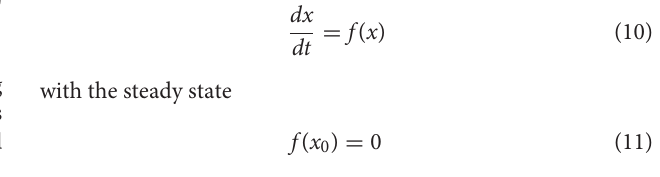
The solution of Equation (5) is according to Equations (7,